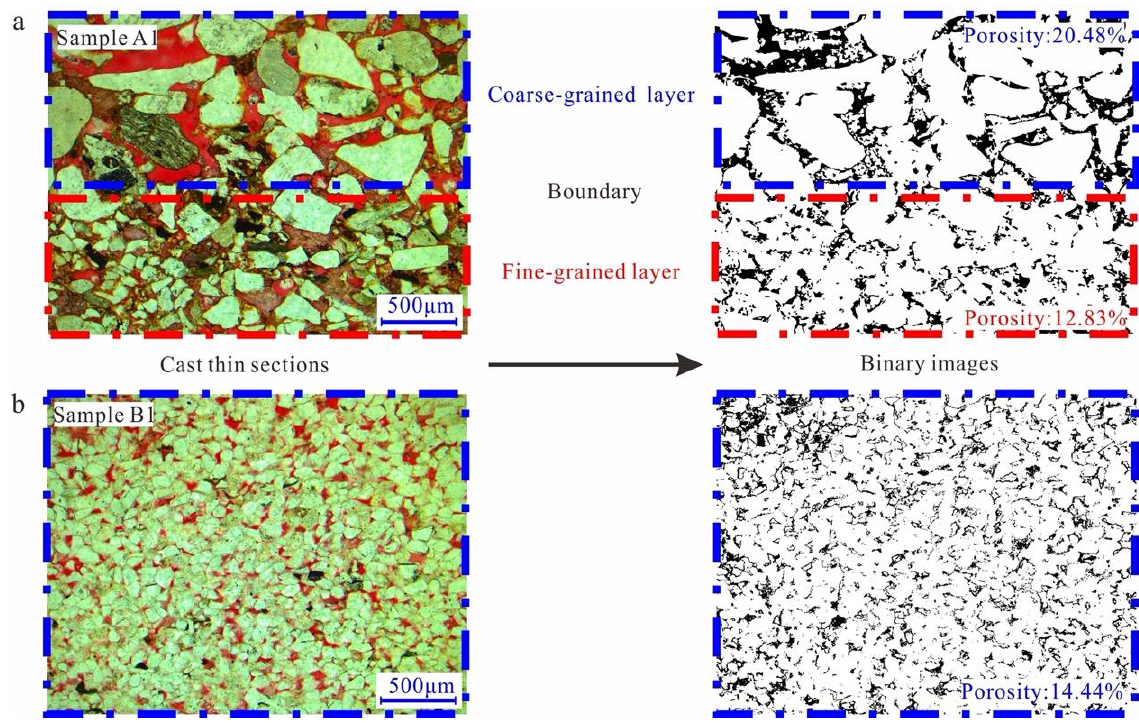
Figure 10. Cast thin sections and binary images of the pore structures of ( a ) Samples A1 and ( b ) B1.